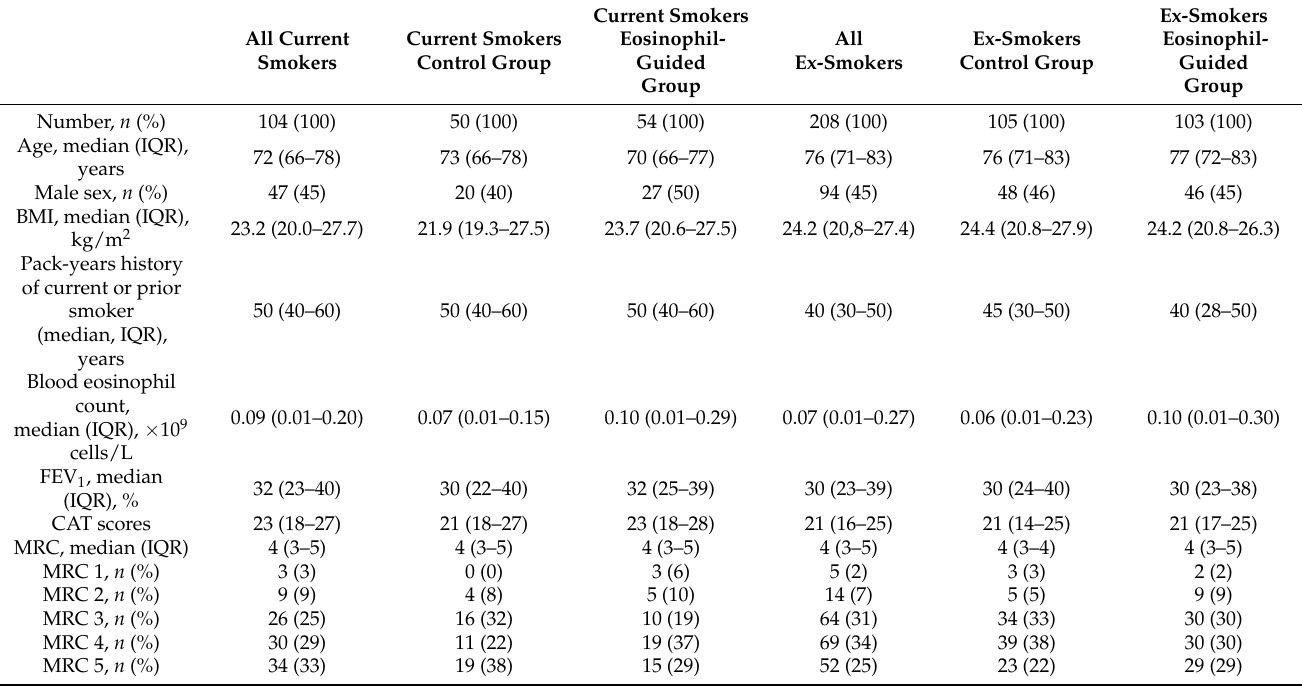
Table 1. Baseline characteristics of current and ex-smokers in the CORTICO-COP trial.